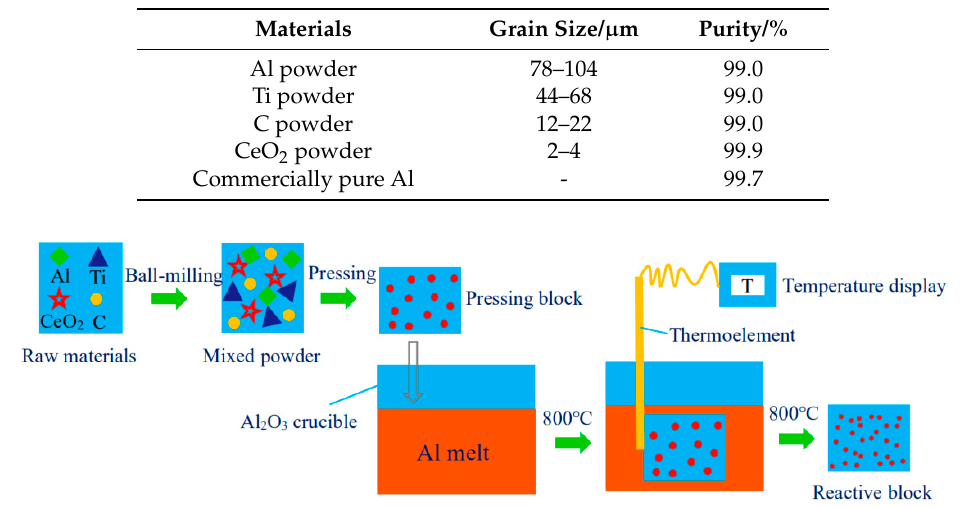
Table 1. Characteristics of materials.